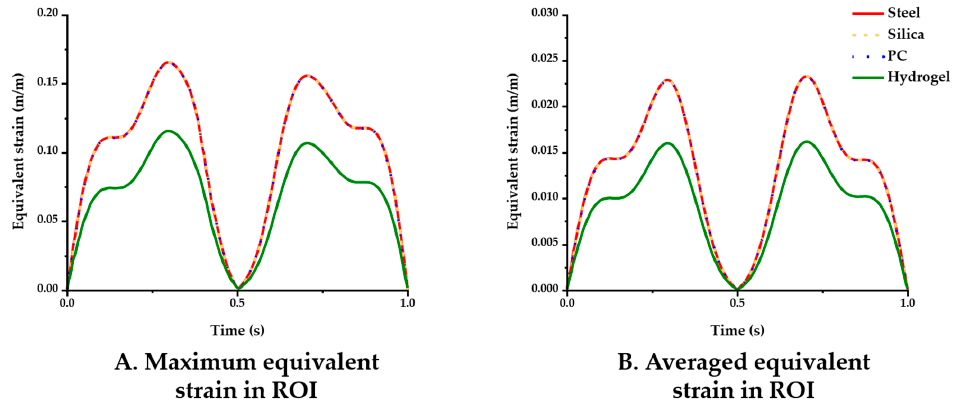
Figure 5. Equivalent strain variation versus time with varying probe materials: steel, silica, PC, and hydrogel (coefficient of friction (COF): 0.3). ( A ) Maximum equivalent strain; ( B ) averaged equivalent strain in the ROI.